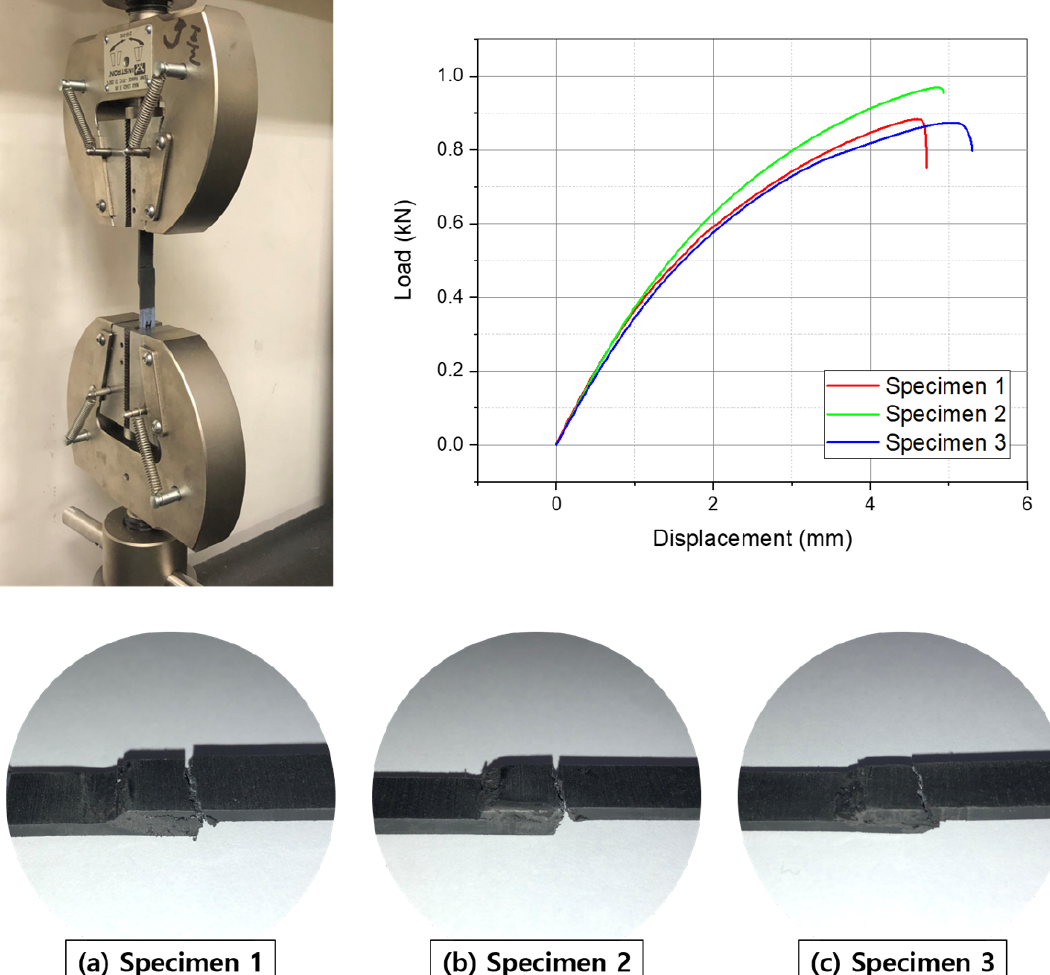
Figure 7. Adhesion failure after tensile tests: ( a ) Weld 1 after 883.8 N, ( b ) Weld 2, 816.7 N, and ( c ) Weld 3, 873.9